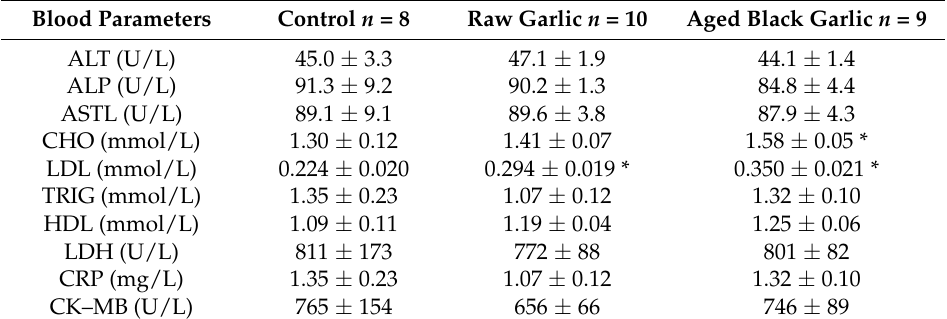
Figure 2. The effects of raw and aged black garlic on bodyweight. Upon conclusion of the treatment with raw (RG) and aged black garlic (ABG) bodyweight was measured. Results are expressed as mean ± SEM. n = 9 in each group. Table 2. Blood parameters measured from vehicle-, raw- and aged black-treated animals. Blood